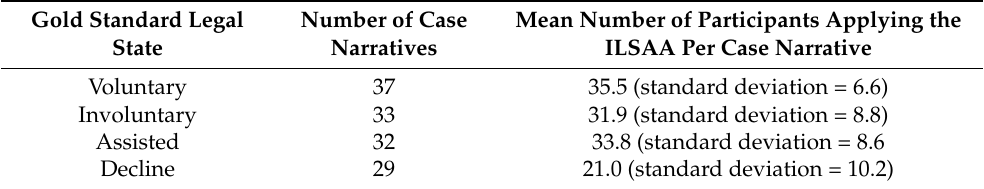
Table 1. Gold standard legal states of the case narratives and mean number of participants applying the ILSAA per case